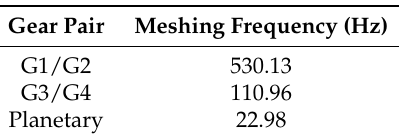
Table 5. Meshing frequencies of the gearbox operating at 1445.8